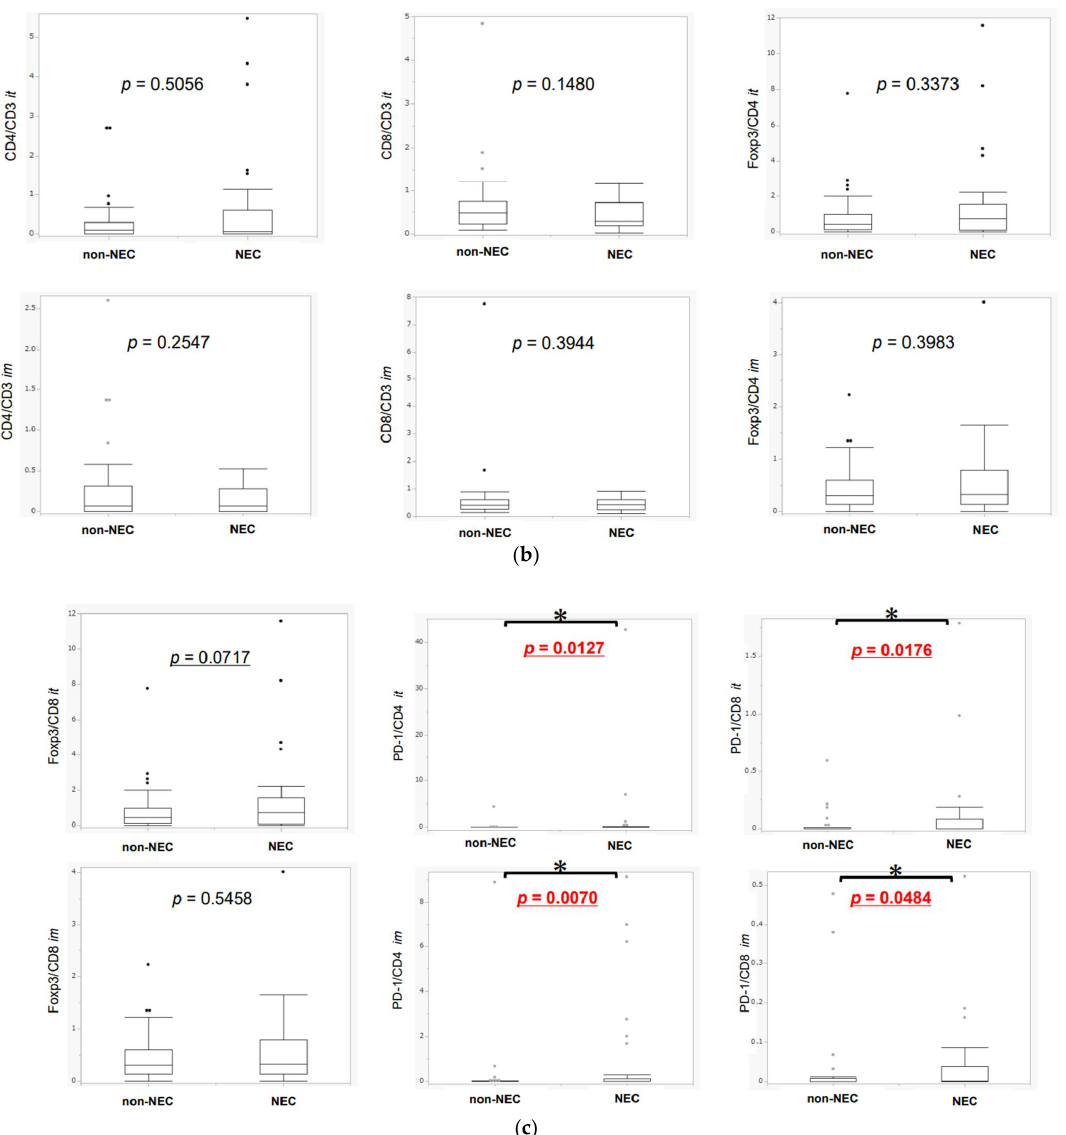
Figure 4. The difference in the abundance of lymphocytes expressing different markers between NEC and non-NEC components in the same case (Wilcoxon signed-rank test). ( a ). PD-1-positive lymphocytes infiltrated into the NEC components more abundantly than the non-NEC components in invasive margins (it: p = 0.1342, im: p = 0.0134). There were no significant differences in the abundances of CD3- and Foxp3-positive lymphocytes, but more lymphocytes infiltrated into the NEC components than the non-NEC components in both intra-tumoral areas and invasive margins. The points are outliers. * it: intra-tumoral, im: invasive margin; NEC, neuroendocrine; non-NEC, non-neuroendocrine. ( b ). There were no significant differences in the CD4/CD3 and Foxp3/CD4 ratios. However, the CD8/CD3 ratio for infiltrating lymphocytes was lower in the NEC than in the non-NEC component in intra-tumoral areas (CD8/CD3 it: p = 0.1430). For infiltrating lymphocytes, it was higher in the NEC component than the non-NEC component in intra-tumoral areas. The points are outliers. * it: intra-tumoral, im: invasive margin. ( c ). The Foxp3/CD8 ratio for infiltrating lymphocytes was higher in the NEC component than the non-NEC component in intra-tumoral areas (Foxp3/CD8 it: p = 0.0717, im: p = 0.5458). Both PD-1/CD4 and PD-1/CD8 ratios in infiltrating lymphocytes were significantly higher in the NEC component than in the non-NEC component in intra-tumoral areas (PD-1/CD4 it: p = 0.0127, im: p = 0.0070, PD-1/CD8 it: p = 0.0176, im: p = 0.0484). The points are outliers. * it: intra-tumoral, im: invasive